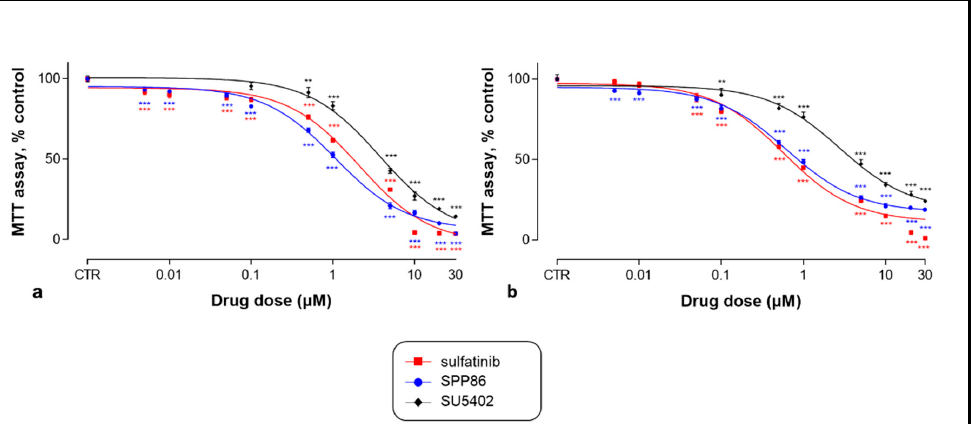
Figure 2. Dose-dependent effect of SU5402, sulfatinib and SPP86 on cell viability of TT ( a ) and MZ-CRC-1 ( b ) cell lines, as measured by the MTT assay. Cells were incubated for 6 days with vehicle (control) or with the drug at different concentrations, as described in Material and Methods. Dose response curves were expressed as nonlinear regression (curve fit) of log (concentration drug) versus the percentage of control. Values represent the mean and standard error of the mean of at least three independent experiments in six replicates. **: p < 0.01, ***: p < 0.001, CTR: control, MTT: 3-(4,5-dymethylthiazol-2-yl)-2,5-diphenyltetrazolium